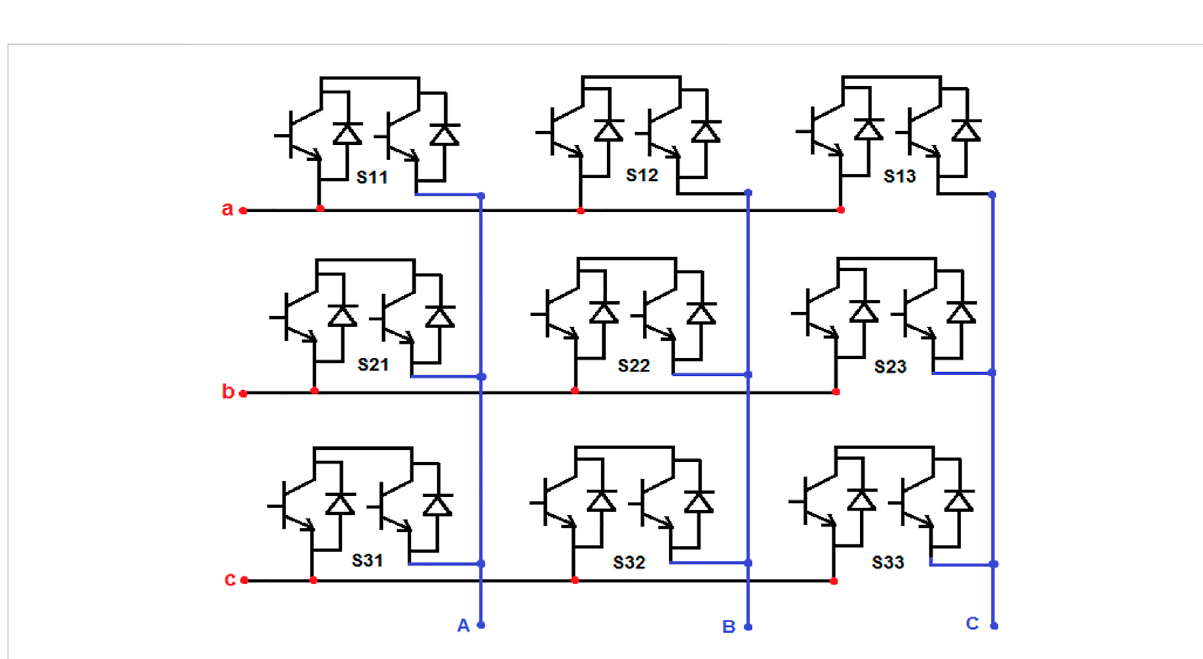
FIGURE 2 3-Phase to 3-phase